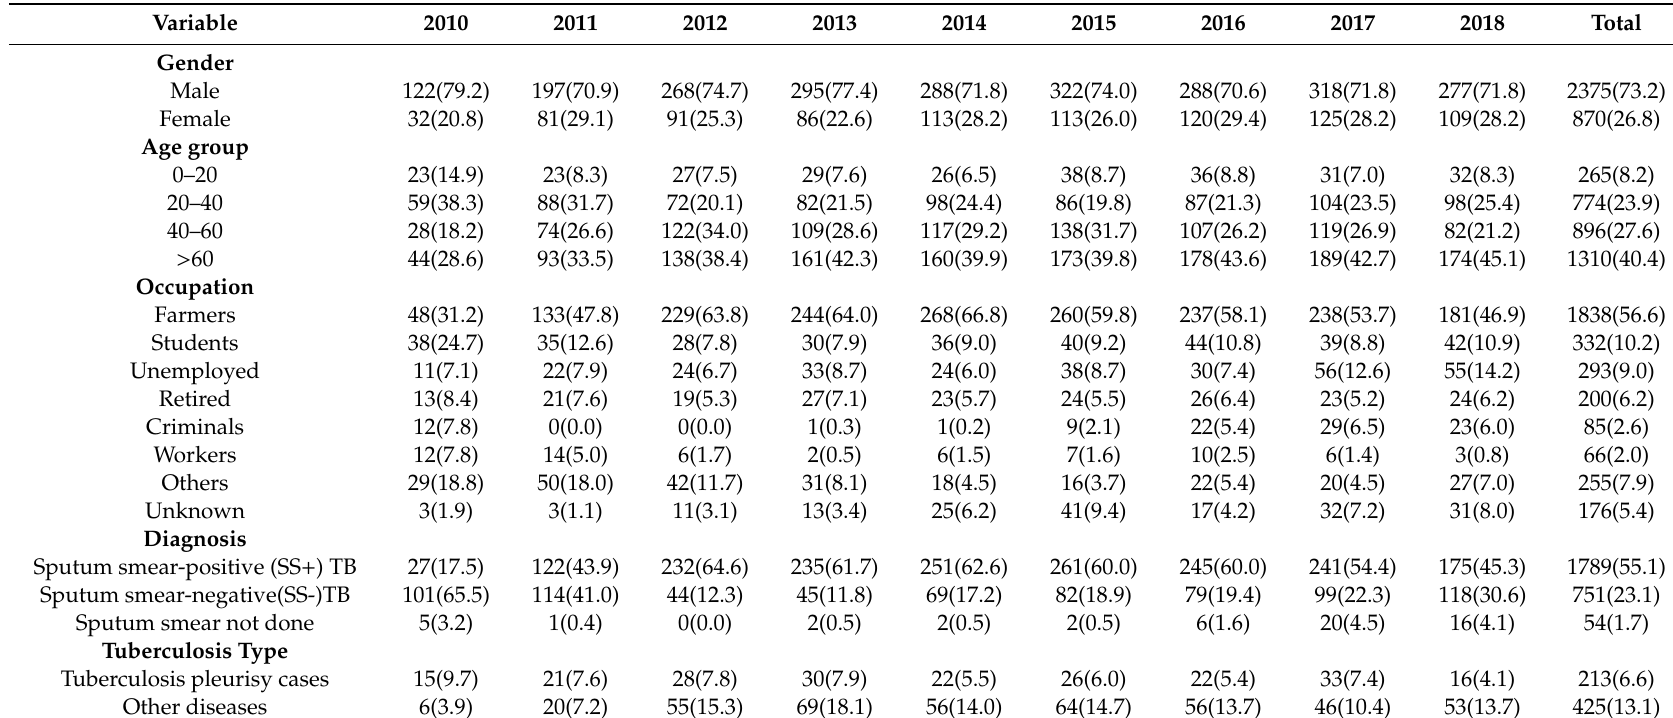
Table 1. Characteristics of all 3245 tuberculosis cases in the new urban area of Nanchang,